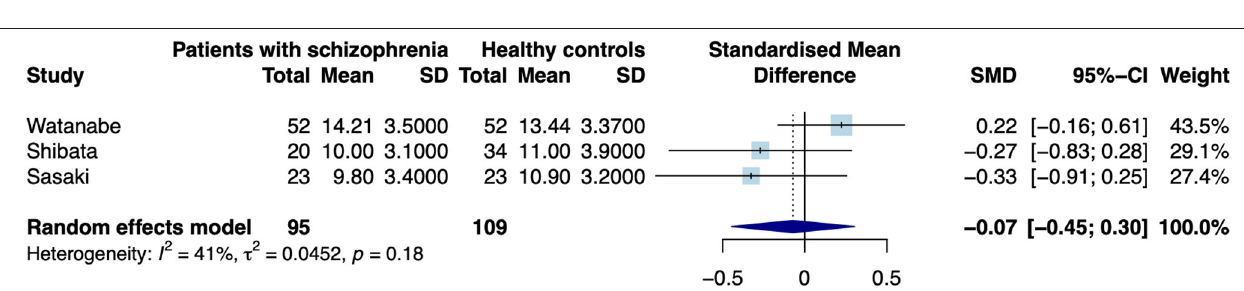
FIGURE 3 | Forest plot of random effects analysis of mean group differences. Filled squares represent estimates per study and whiskers represent confidence intervals. Diamonds represent the point estimates with confidence intervals for an overall estimate in subgroups and the overall pooled effect across all studies.